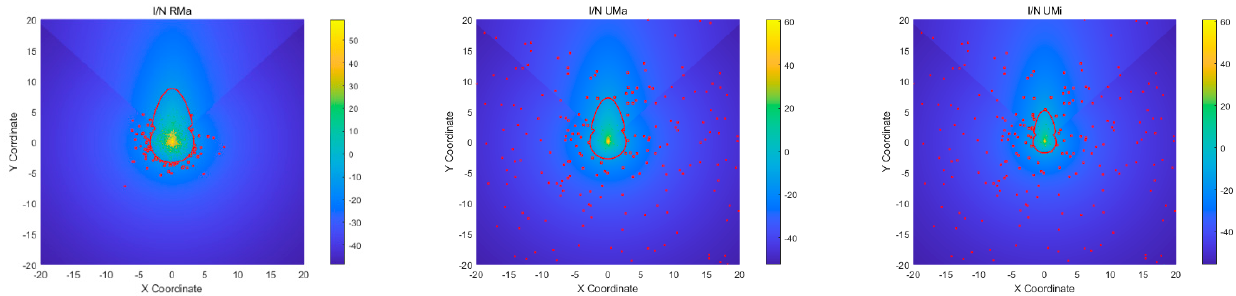
Figure 18. RMa, UMa, and UMi scenarios with an ES antenna elevation angle of 15° for the conventional omnidirectional antenna.